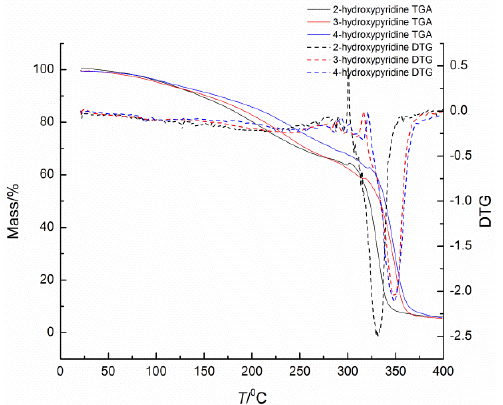
Figure 3. TGA ‐ DTG thermograms of blocked isocyanates.